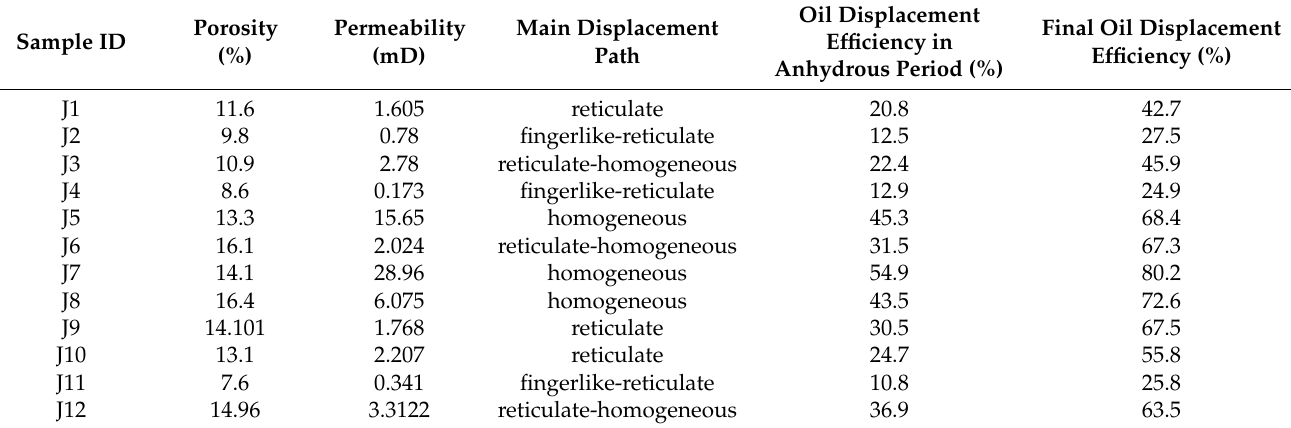
Table 10. Visualizing water-flooding oil characteristic